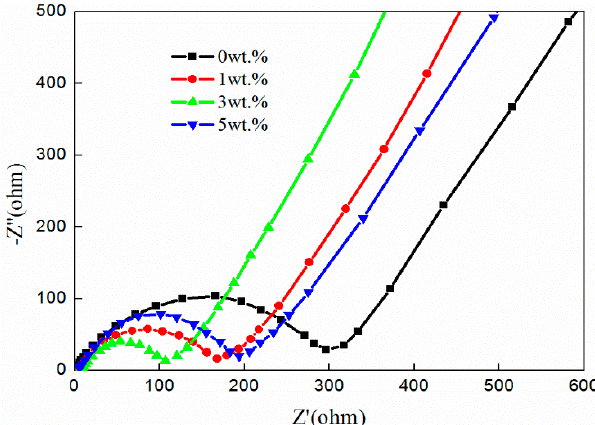
Figure 7. EIS of LFP/C-xZnO (x = 0, 1wt%, 3wt%, 5wt%) samples.